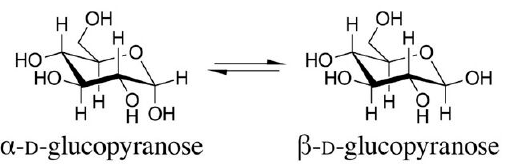
Figure 2. The structures of the α - and β -D-glucopyranose isomers (anomers).